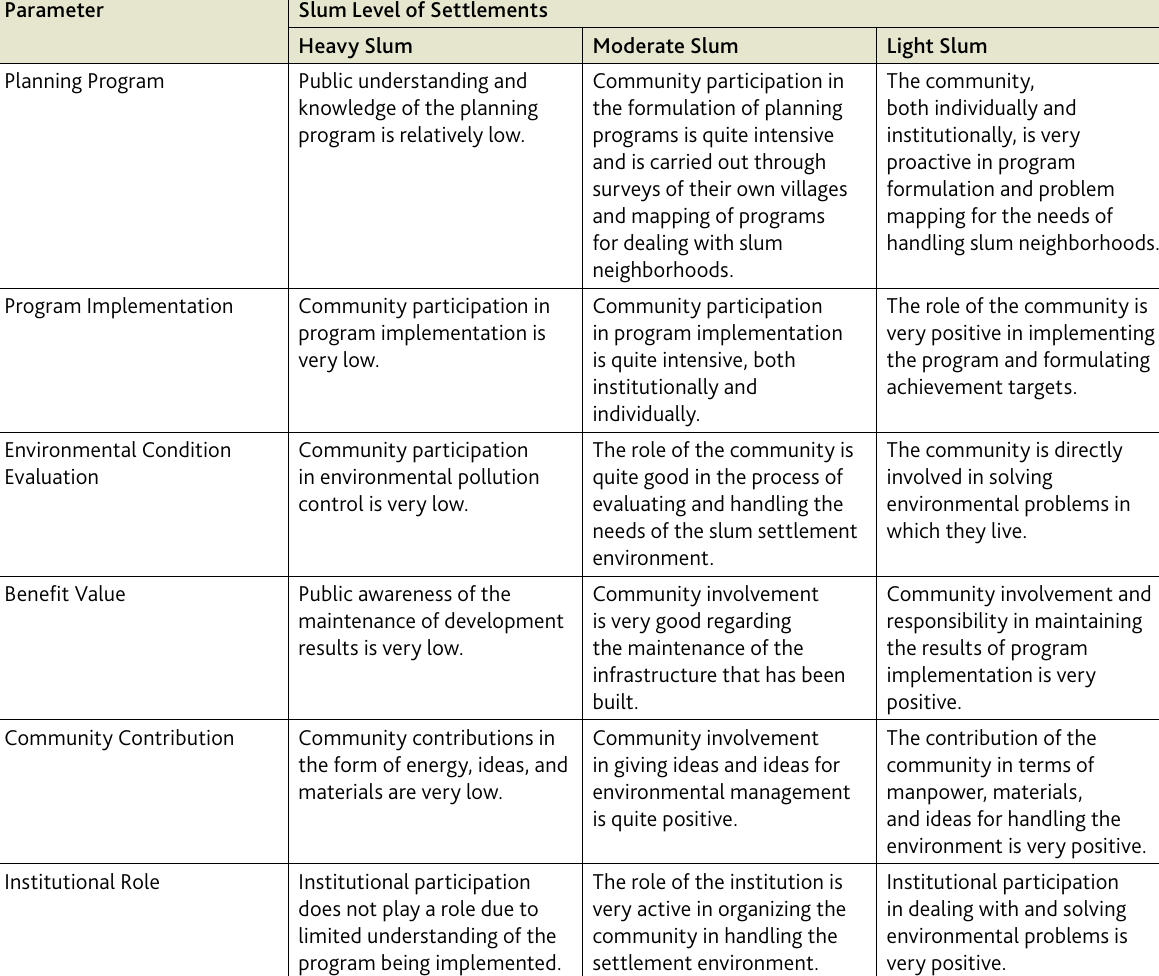
Table 1. Comparison of community participation in handling slums settlement in Makassar